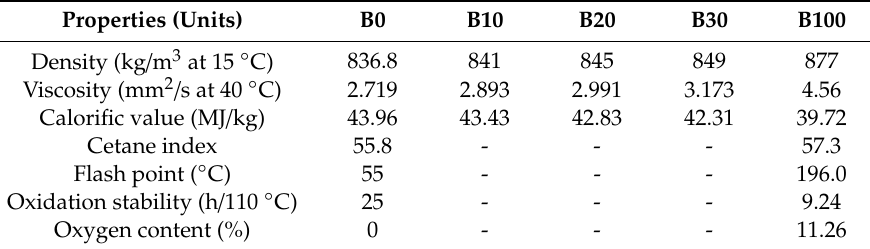
Table 1. Properties of B0, B10, B20, B30, and B100.